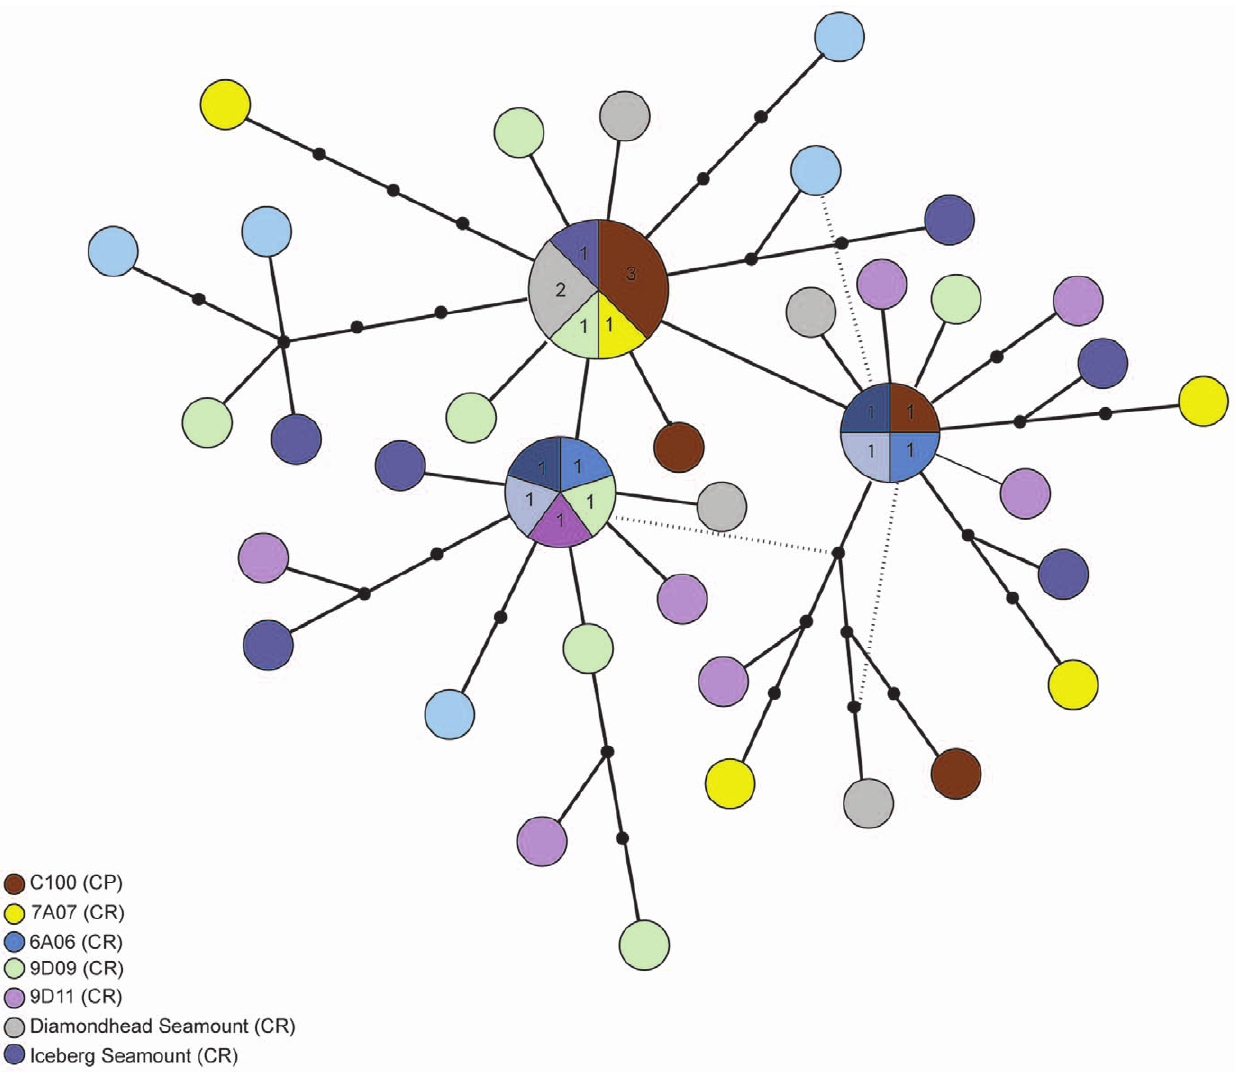
Figure 5. TCS haplotype network for Munidagracilis , COI sequences. Each circle represents an observed haplotype and the circles are proportional to the number of individuals sampled with that haplotype. Each color indicates a sampling site and when a haplotype was present at multiple sites, a pie chart indicates the proportions with absolute numbers appearing in text in the pie chart. Each line connecting colored circles represents a single nucleotide sequence change. Lines with small black circles indicate interior haplotypes not found in the dataset (multiple nucleotide changes between sampled haplotypes).